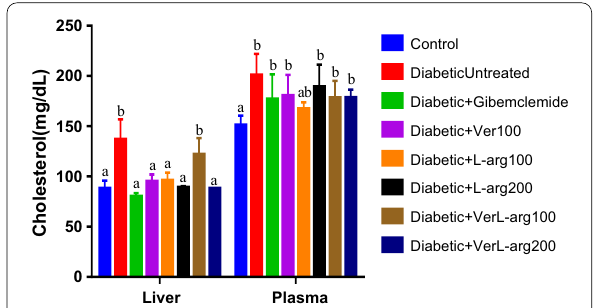
Fig. 7 Total cholesterol concentration in diabetic mice treated with verbenone, L-arginine and ratios of verbenone after 14 days treatment. Values are expressed as mean Values with different superscripts are significantly different at p < 0.05. VerL-arg verbenone L-arginine (1:1 v/m) = +